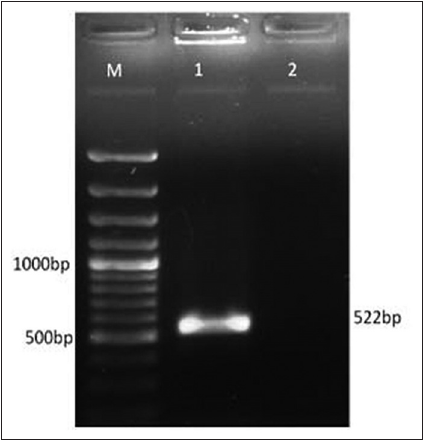
Figure-1: Confirmation of C. chauvoei by polymerase chain reaction (PCR) based on 16S-23S rDNA spacer